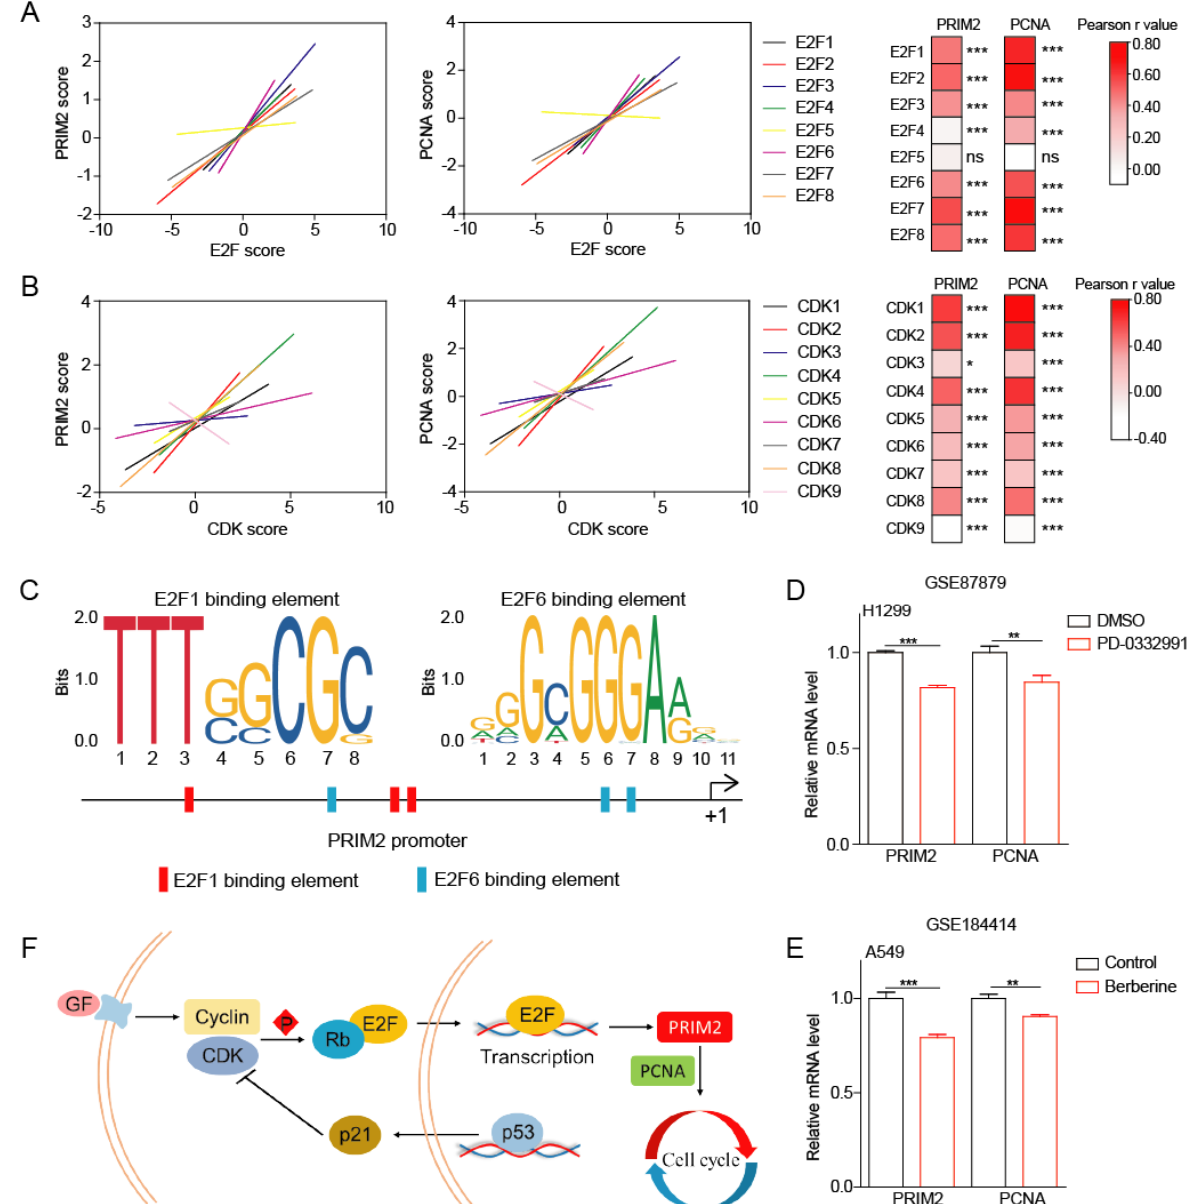
Figure 4. The p53/RB pathway–PRIM2–PCNA axis promotes cell growth. ( A , B ) The expression cor- relation between PRIM2 and E2F/CDK family members. ( C ) The predictive analysis of transcription factor E2F-binding elements on the PRIM2 promoter. ( D ) The PRIM2 and PCNA mRNA expression levels in H1299 cells with the treatment of PD-0332991 from the GEO database. ( E ) The PRIM2 and PCNA mRNA expression levels in A549 cells with the treatment of Berberine from the GEO database. ( F ) Schematic representation of PRIM2 regulation of the cell cycle. * p < 0.05; ** p < 0.01; *** p <